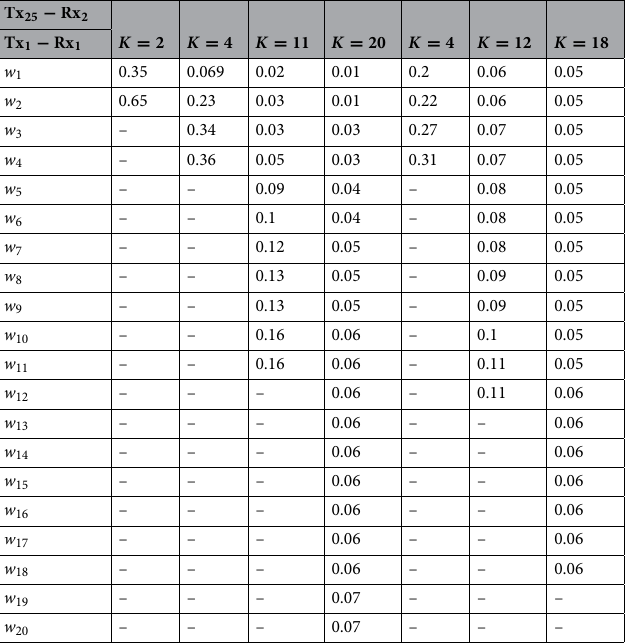
Table 2. Weight parameters, w for the GMs with K equal to 2, 4, 11, 12, 18, and 20 for the Tx 1 Tx 25 Rx 2 −